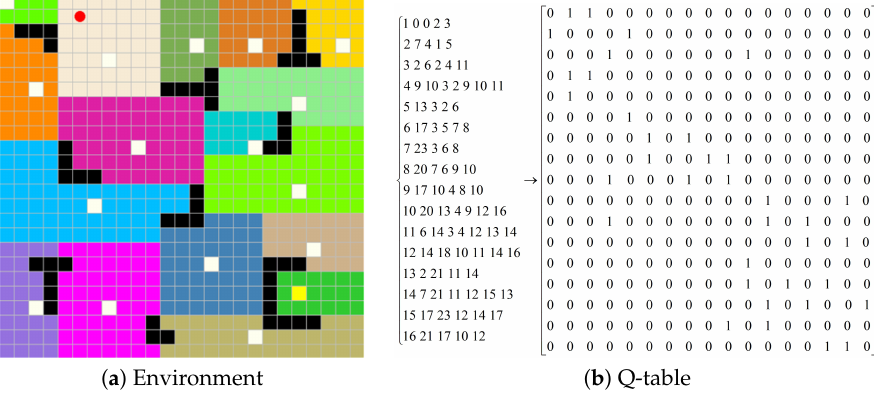
Figure 12. ( a ) The simulation environment generated according to Figure 11 (same as Figure 10a). ( b ) Q-table updated according to the topological relationship in ( a